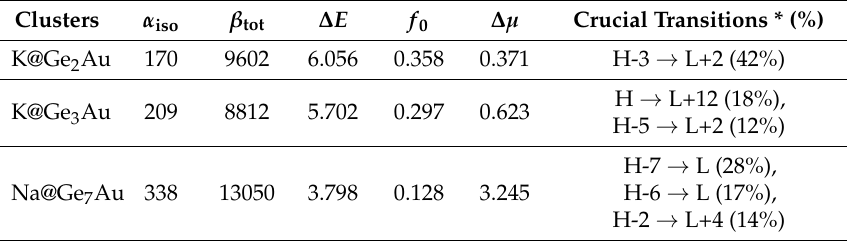
Table 1. The isotropic polarizabilities ( α iso , in a.u.), static first hyperpolarizability ( β tot , in a.u.), transition energy (∆ E , in eV), maximum oscillator strength ( f 0 , in a.u.), and the change in dipole moment (∆ μ , in Debye) for crucial excited states of the following clusters.